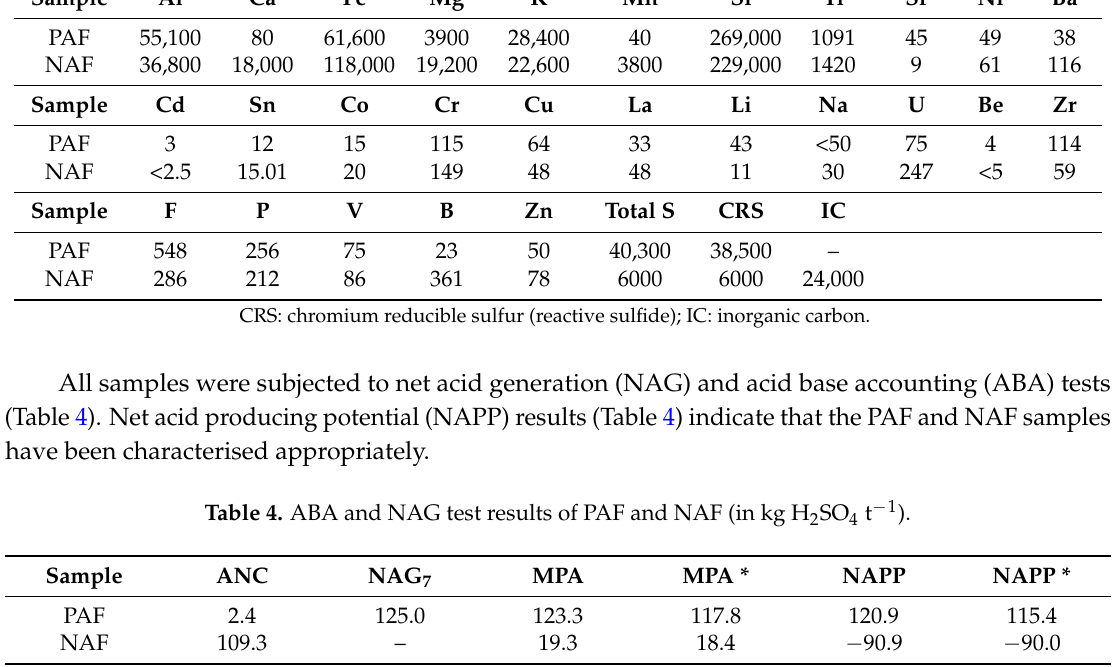
Table 3. Bulk assay results for NAF and PAF wastes (all data in ppm). Sample